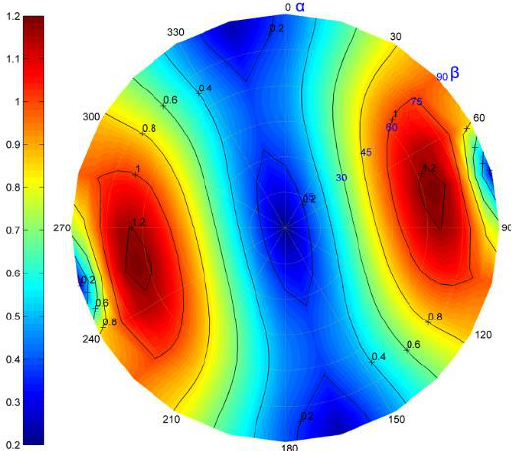
Figure 10. The risk of failure for fractures at different angles (where, α represents the fracture direction, β represents the fracture dip angle, the color value represents the slip risk of the fracture).